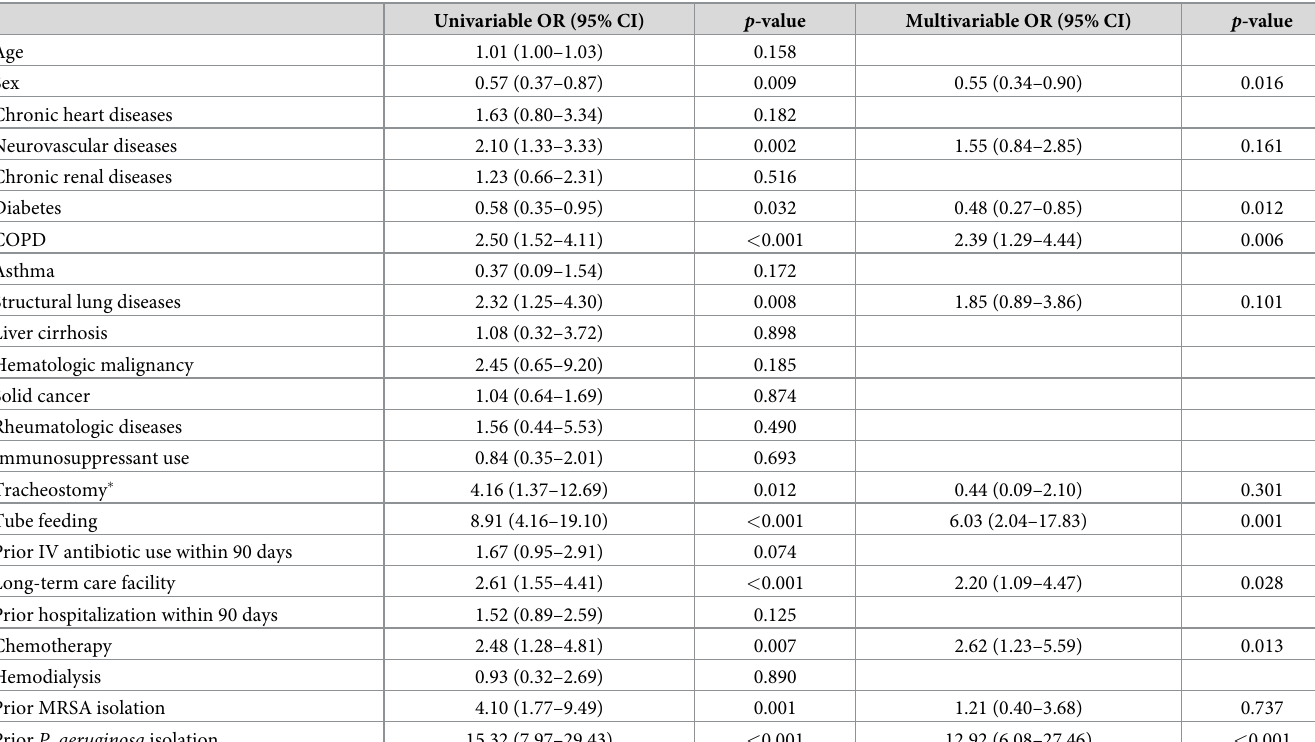
Table 4. Univariable and multivariable analysis of risk factors for P . aeruginosa infection in CAP and HCAP